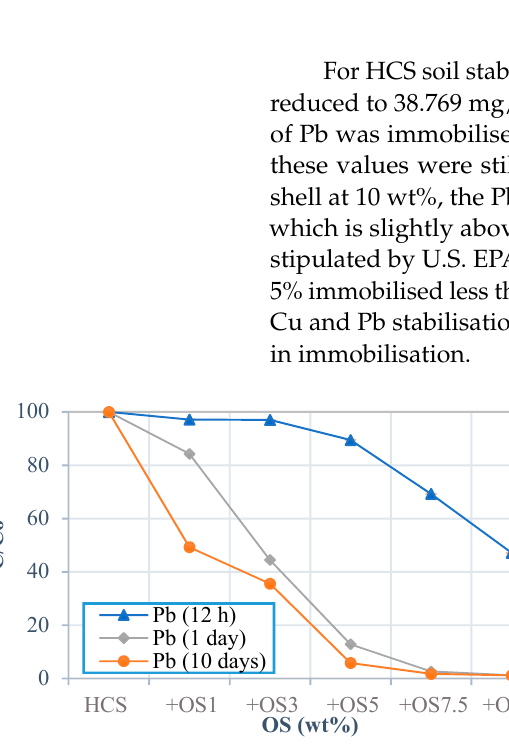
Figure 4. Pb and Cu concentrations in the HCS treated with oyster shell obtained through the TCLP test at different contact times (12 h, 1 day and 10 days). (The number after the binder abbreviation represents mass percentage (e.g., OS3 means 3 wt% of oyster shell). (Refer to Table S8).